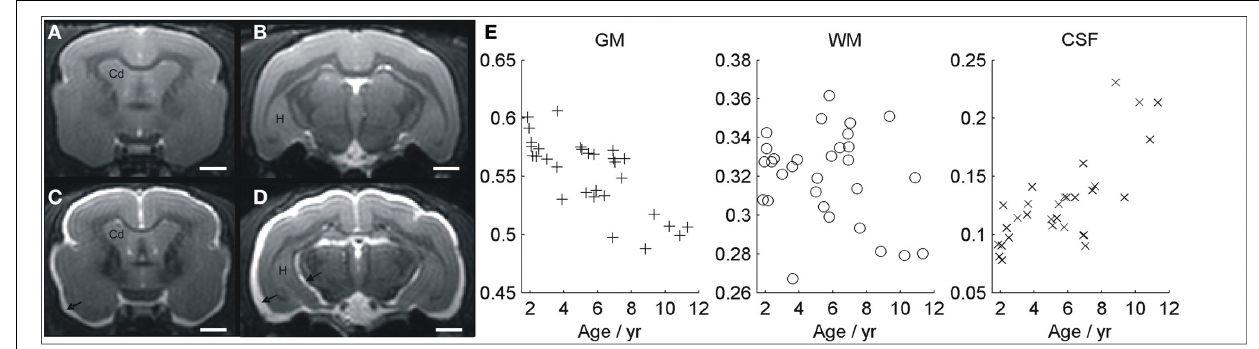
FIGURE 3 | MR image showing a young non-atrophied animal (A,B) compared with an example of old atrophied lemur (C,D). An increased cerebrospinal fluid associated to a severe atrophy process can be seen in the